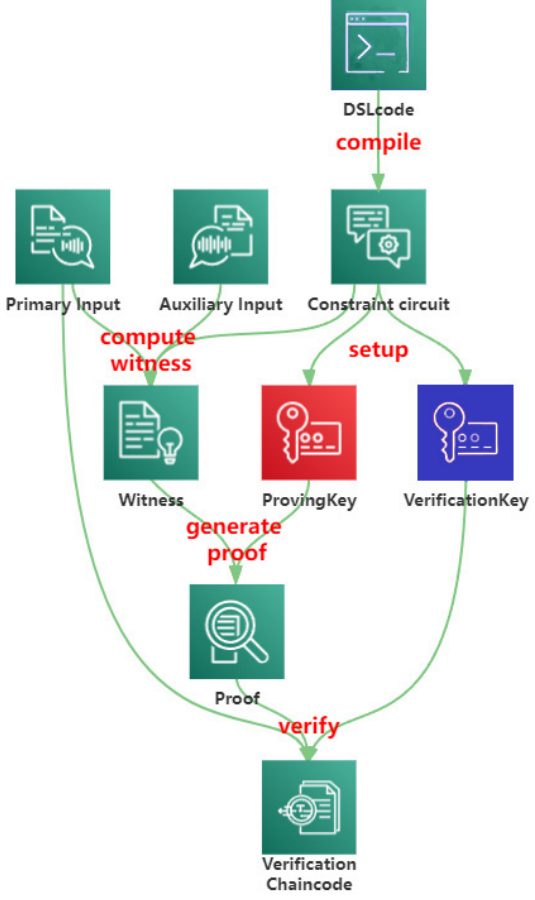
Figure 1. The process of go-snark.